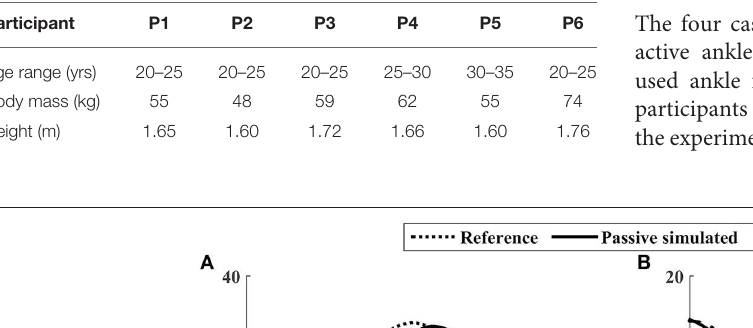
Frontiers in Neurorobotics |